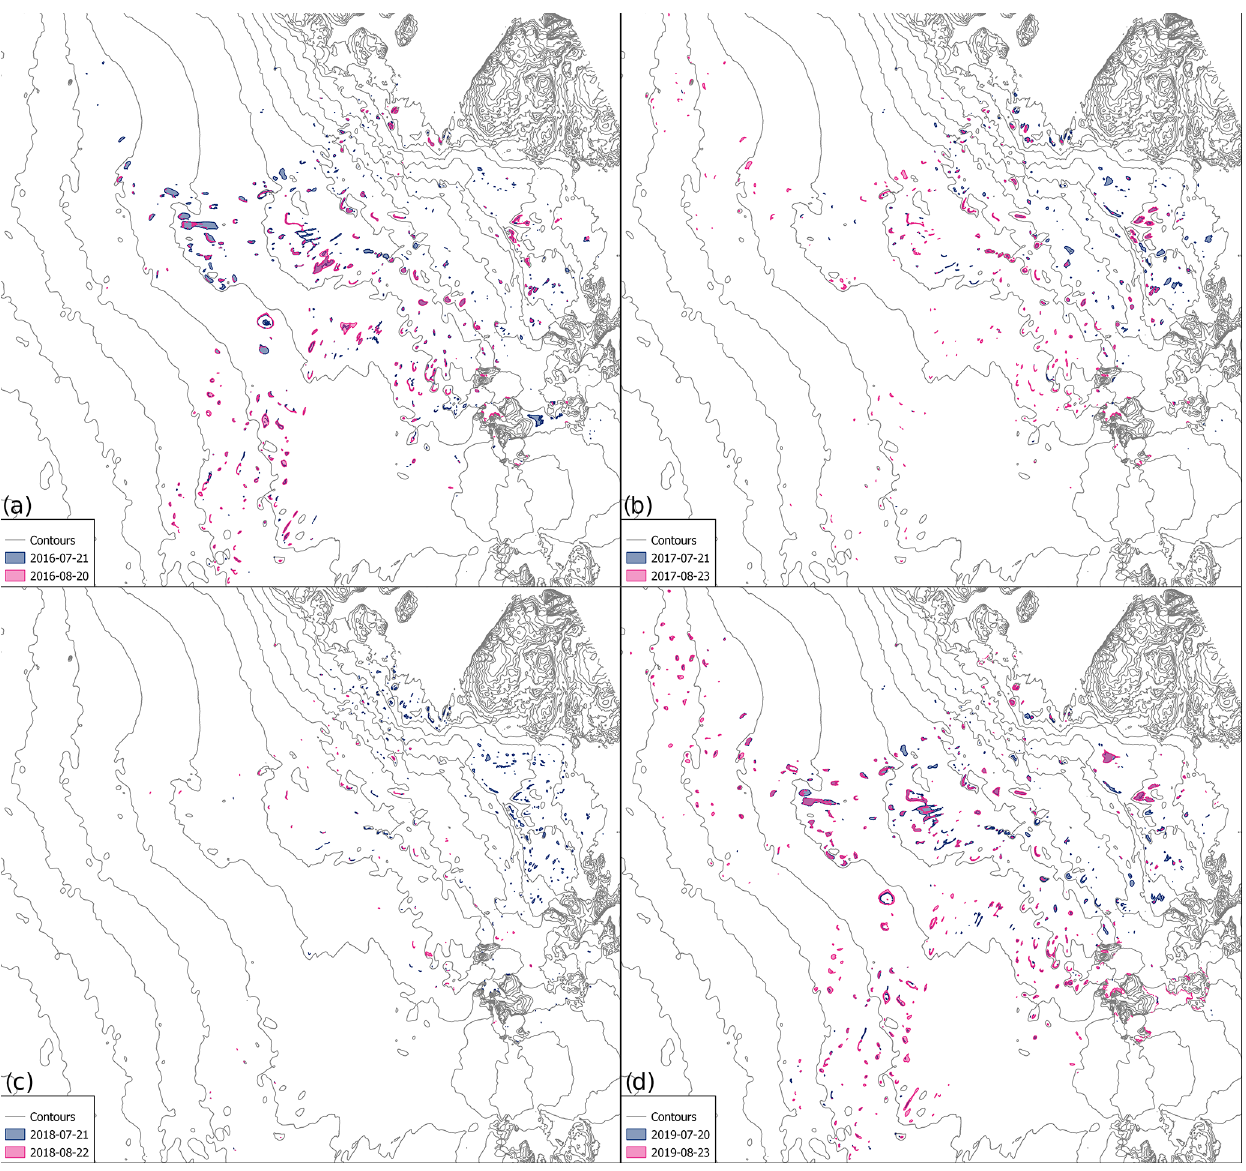
Figure 3. Lake area in July (blue) and August (purple) for 2016 (a) , 2017 (b) , 2018 (c) , and 2019 (d) . Contours are every 100m. Lakes on the tongue have been removed to assess only those controlled by